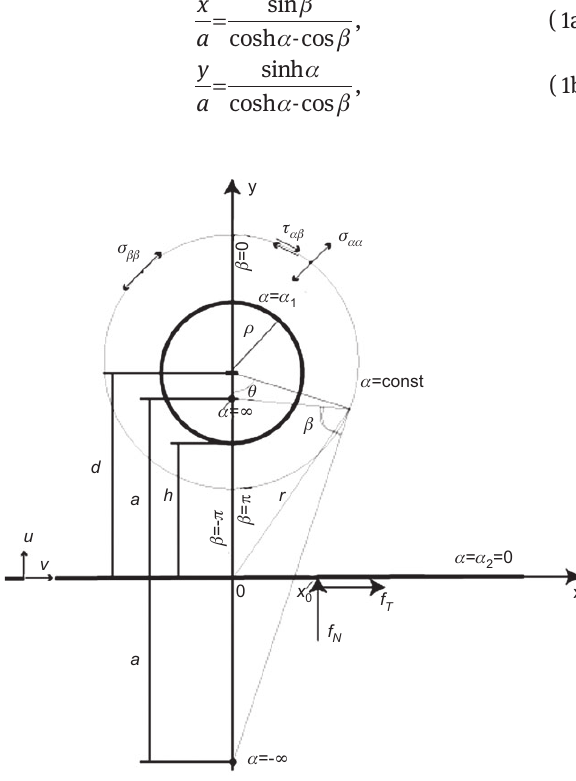
Figure 1 An elastic half-space y ≥ 0 containing a circular hole and e e loaded by linear force f = f + f . The model uses bipolar ( α , β ) and T x N y Cartesian ( x, y ) coordinate systems. The hole and the boundary of = 0, correspondingly. a half-space have coordinates α = α and α = α 1 2 Force is applied at point (0, β ), which corresponds to the Cartesian 0 coordinates( x , 0